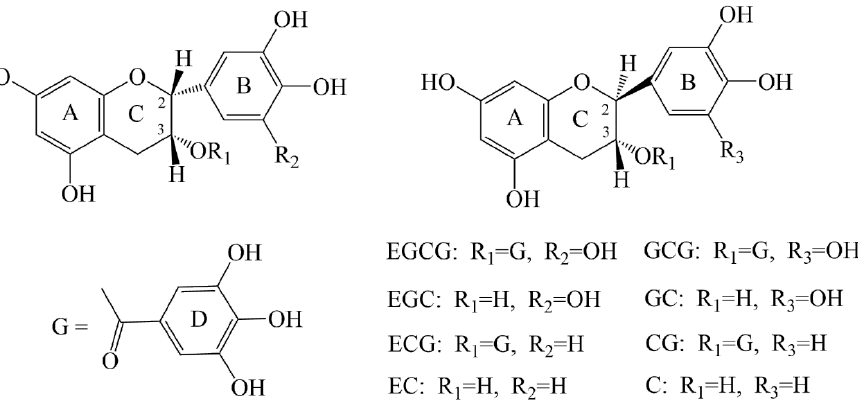
Figure 2. Chemical structures of eight catechin monomers.